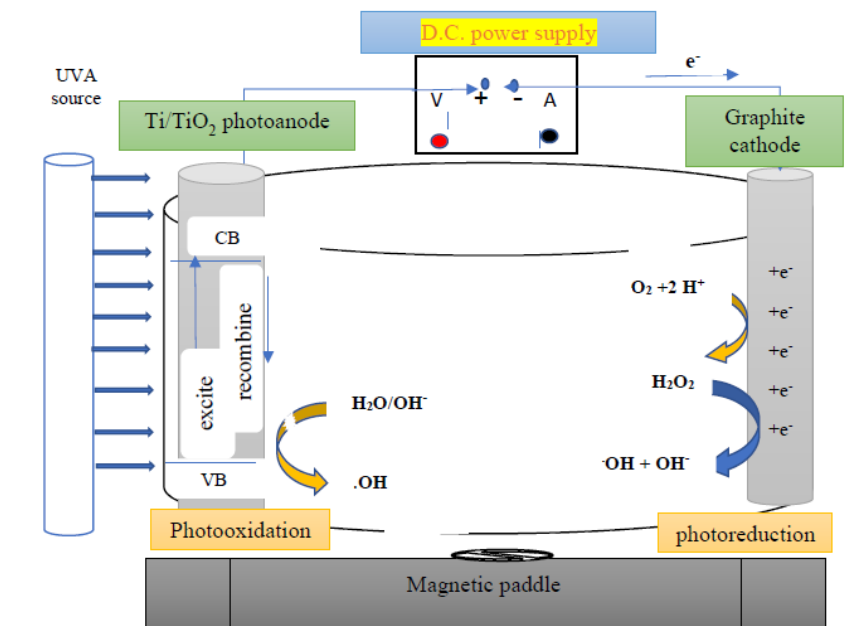
Fig. 2: Schematic diagram of the PEC reactor system